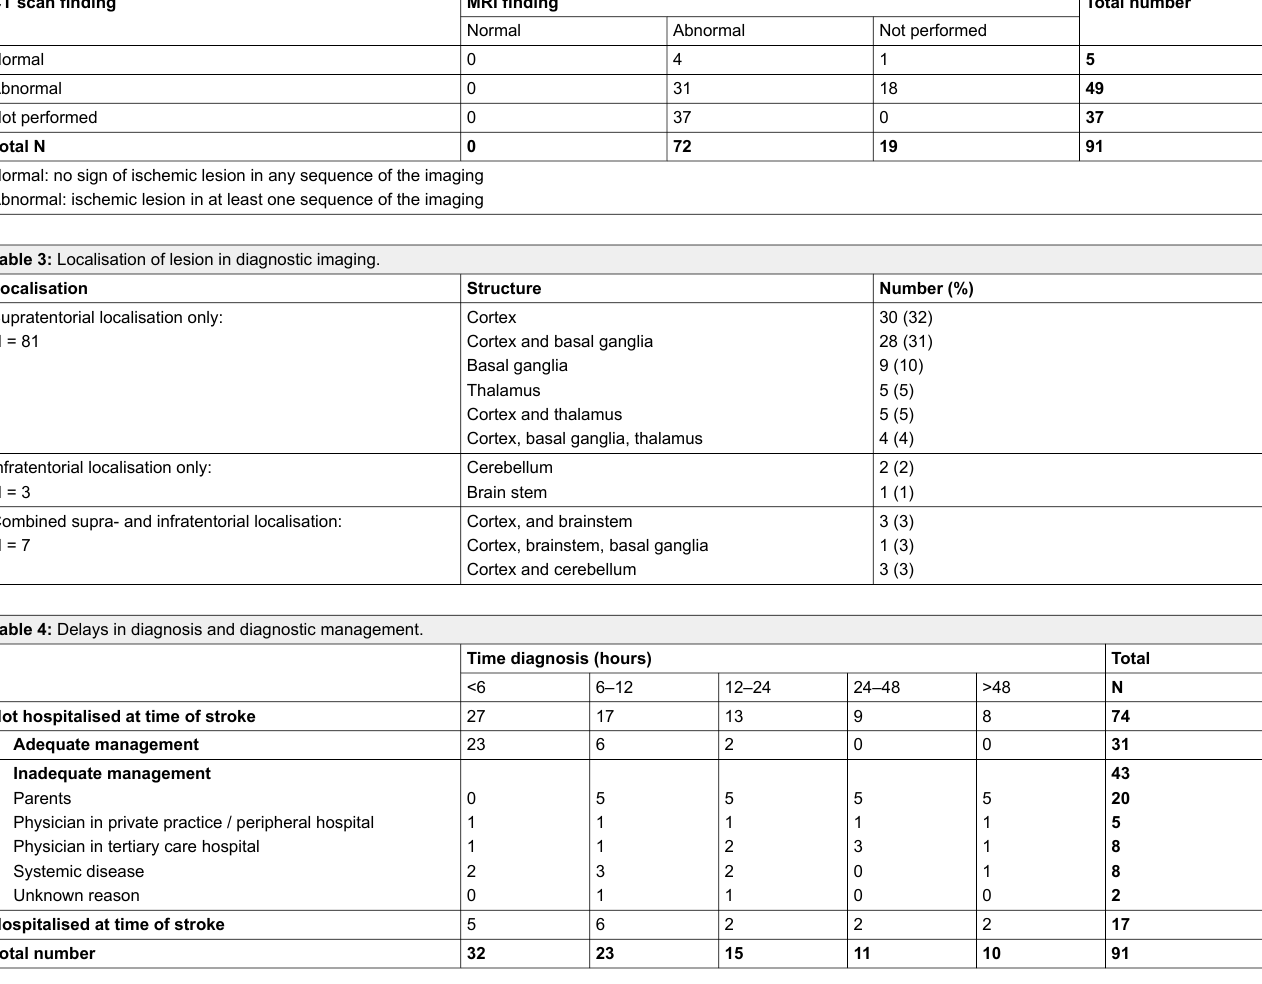
Table 2: Initial diagnostic imaging in 91 children with acute ischemic stroke: comparison of results of CT scan and MRI.